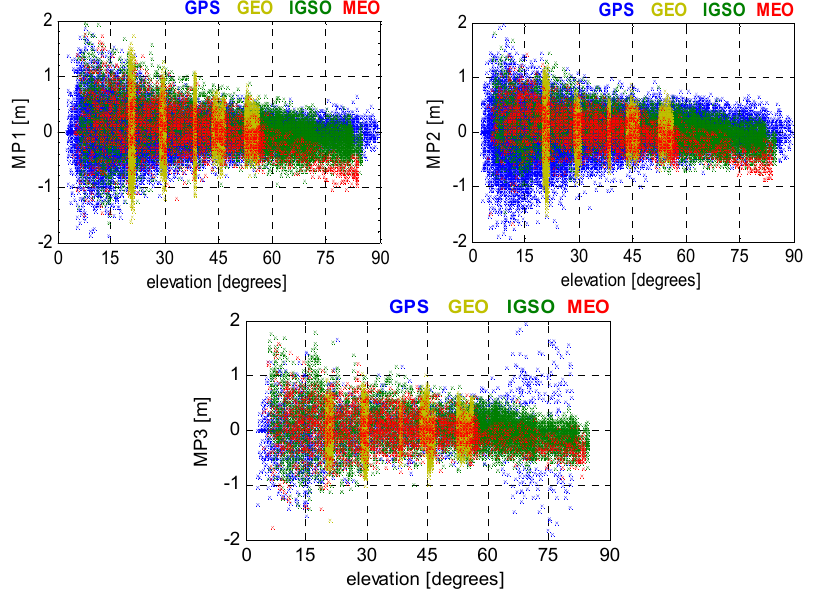
Figure 1. BeiDou and GPS code MP series against elevation angles observed from JFNG (DoY 081/2015).